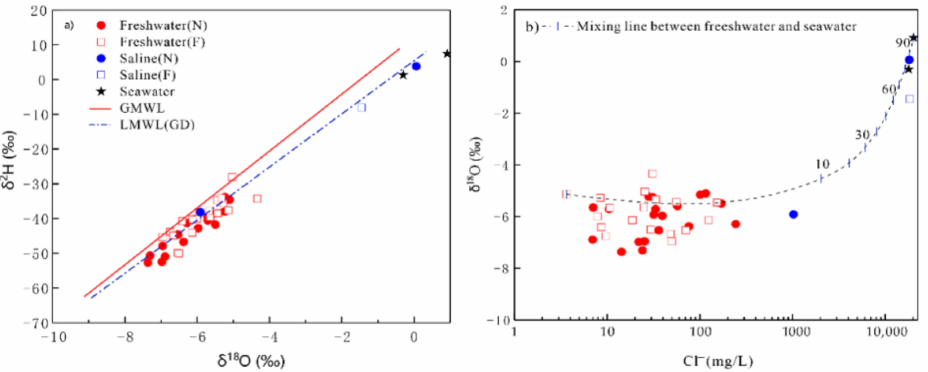
Figure 4. Relationship between ( a ) δ D- δ 18 O isotopes and ( b ) Cl- δ 18 O of underground water in the coastal zone of Guangdong province. ( a ) The red line represents the global meteoric water line (GMWL), and the blue line represents the local meteoric water line (LMWL). ( b ) The black line represents freshwater-seawater mixing line. The starting point is the freshwater end element and the ending point is the seawater end